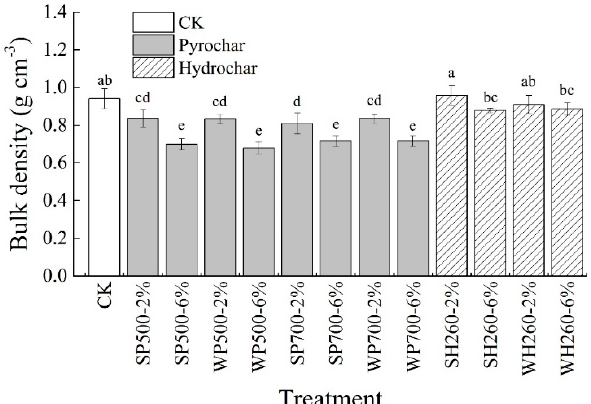
Figure 3. Soil bulk density under different pyrochar and hydrochar treatments after the incubation experiment. Different lowercase letters represent statistical differences at p < 0.05. Error bars represent standard deviations.